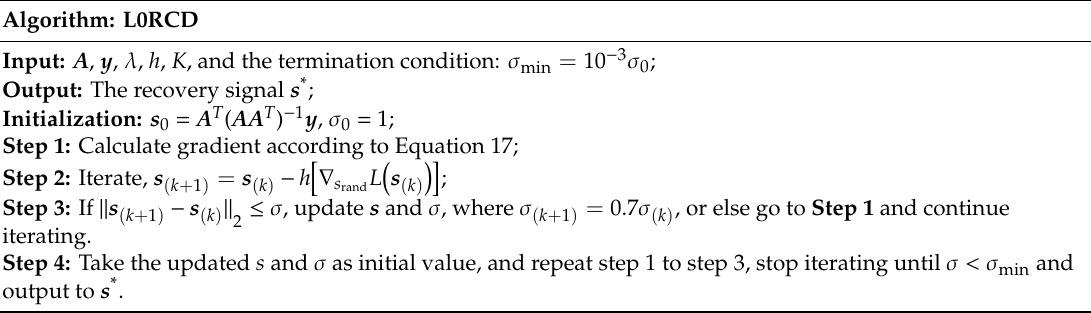
Table 1. The description of the smooth l 0 norm based sparse recovery algorithm using RCD (L0RCD). Algorithm: